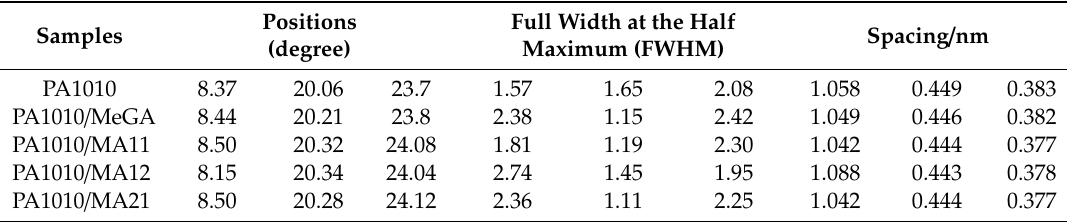
Table 6. XRD di ff raction planes and the lattice spacing for PA1010 and PA1010 with MA complex under investigation.